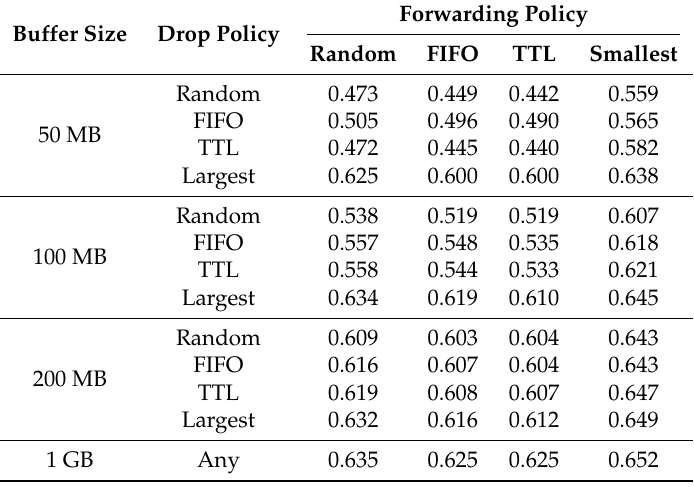
Table 3. Delivery probability for a 24 h TTL (Time to Live) with different buffer sizes and queue